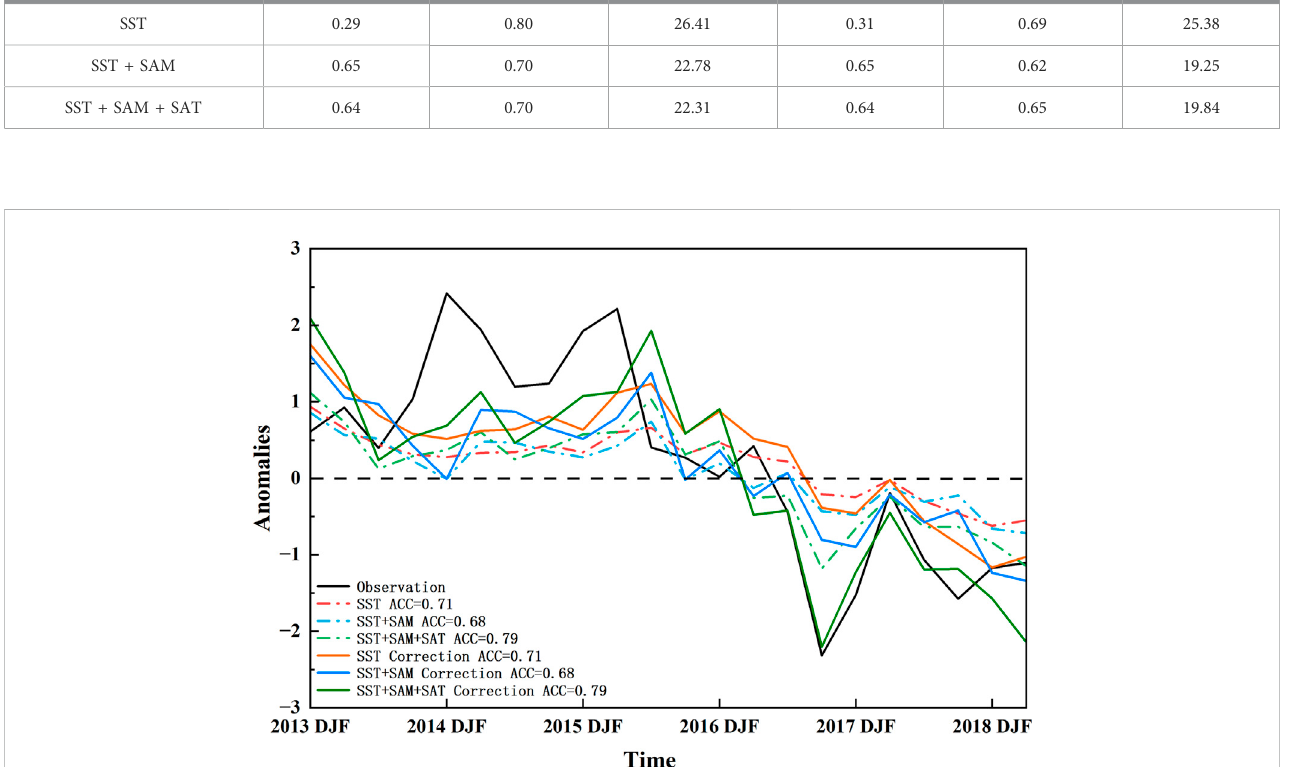
FIGURE 8 Observed, predicted, and corrected Weddell Sea SIC anomaly in prediction period (unit: %). The predicted Weddell Sea SIC anomaly refers to these predictions according to Eqs. 6 – 8, and the corrected ones represent the correction of Weddell Sea SIC anomaly according to Eq. 10. The colorful solid lines represent the predictions, and the dashed lines represent the corrections. The abscissa denotes the austral